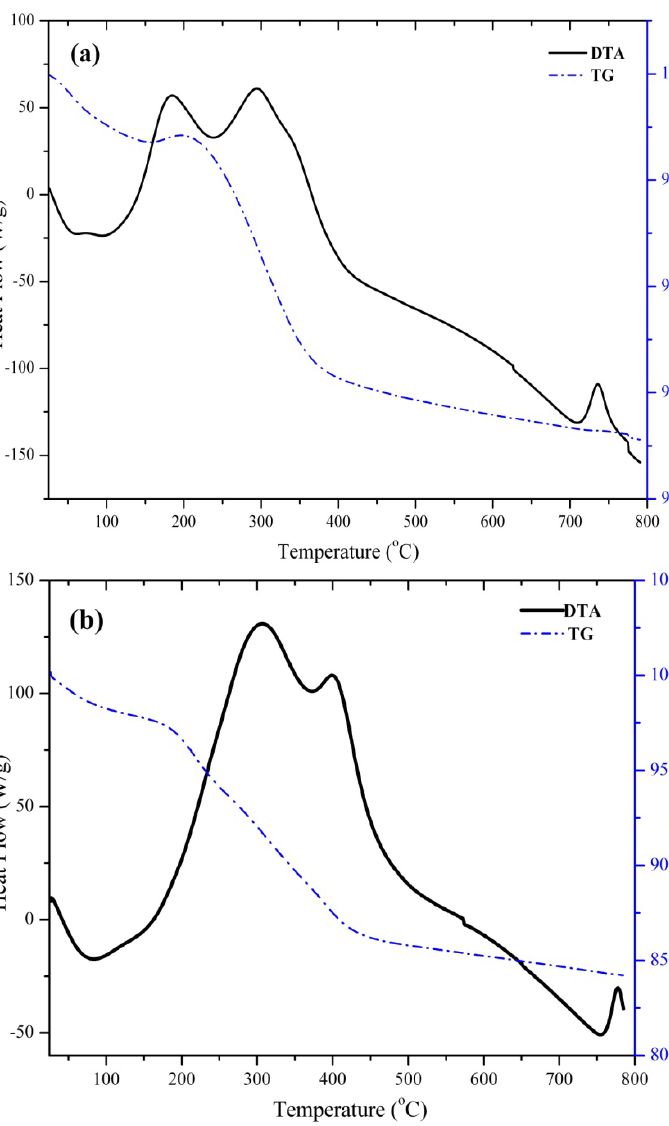
Figure 3. Thermogravimetric analysis-differential thermal analysis (TGA-DTA) curves of ( a ) MNP-NH catalyst and ( b ) MNP-NMe 2 2